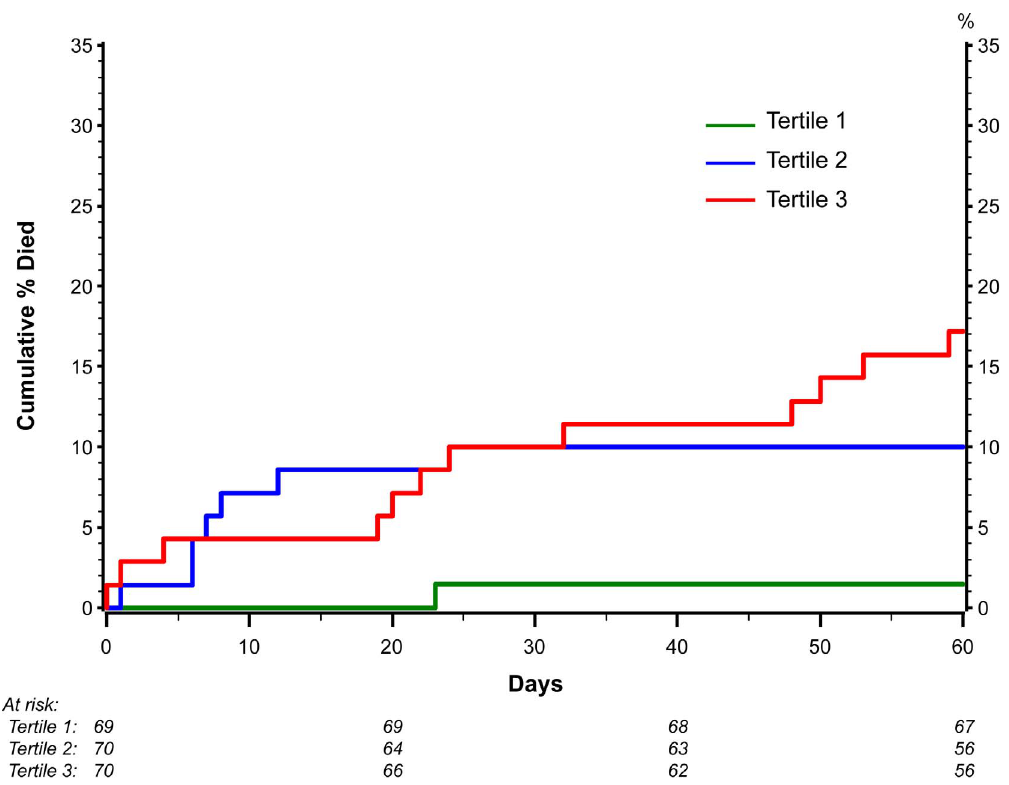
Figure 3. Mortality by tertiles of IL-6 in the FLU 003 study. A Kaplan-Meier graph of cumulative mortality (%) for FLU 003 participants according to baseline levels of IL-6 as grouped into tertiles.